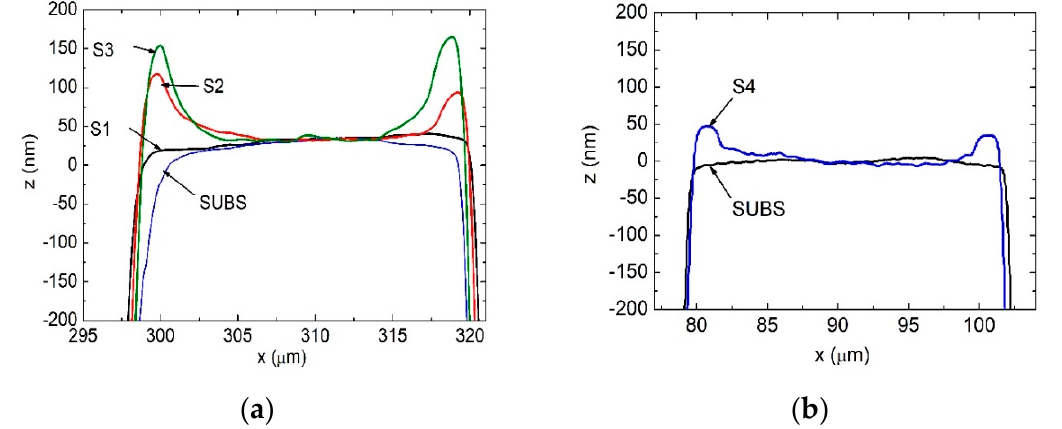
Figure 7. Surface profiles of InGaN/GaN structures grown on substrates with 20 µm wide stripes. All profiles have been shifted in the z-direction to match each other’s height in the center of the stripe. In ( a ) profile SUBS is for GaN substrate, S1—after growth of HT-GaN, S2—after HT-GaN and InGaN, S3 after HT-GaN, InGaN, and 5QWs. In ( b ) profile SUBS is for GaN substrate and S4 after growth of HT-GaN + LT-GaN. See text and Table 2 for more details.